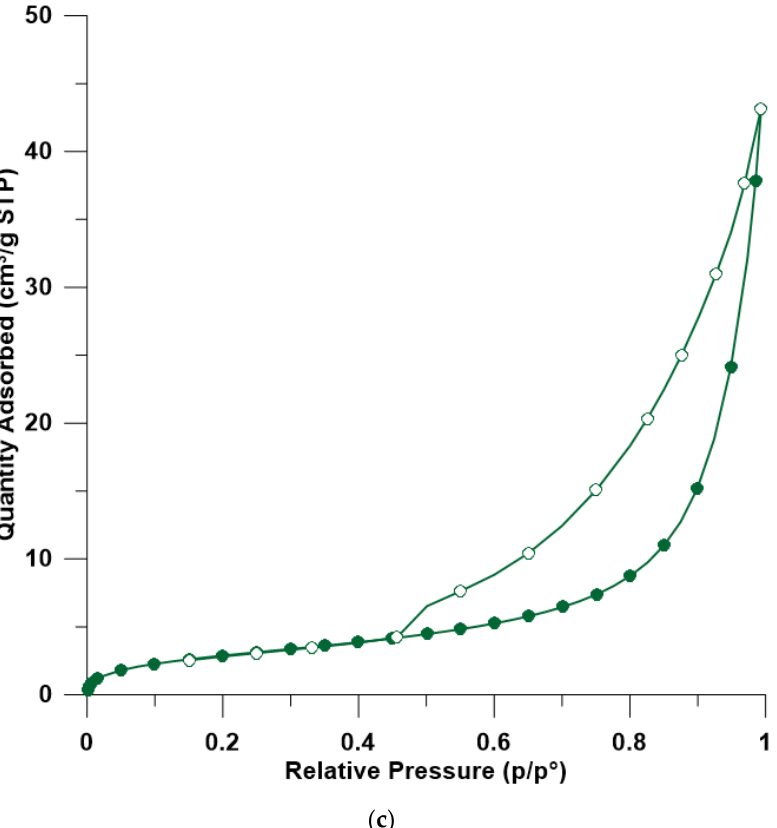
Figure 5. Comparison of N 2 adsorption and desorption isotherms at − 196 ° C for: ( a ) BENT, ( b ) HD-TX-48, and ( c ) TX-48. Filled symbols—sorption of N 2 ; unfilled symbols—desorption of N 2 . Table 2. The textural parameters of BENT, HD-TX-48, and